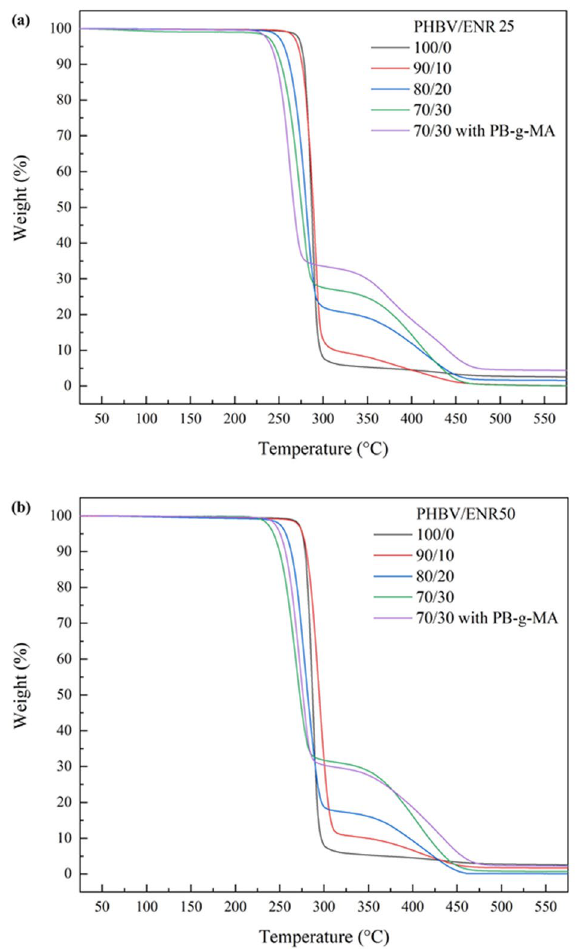
Figure 2. The TGA thermogram of neat PHBV (100/0) and PHBV/ENR blends with and without compatibilizer (PB-g-MA), ( a ) PHBV/ENR-25 blends, and ( b ) PHBV/ENR-50